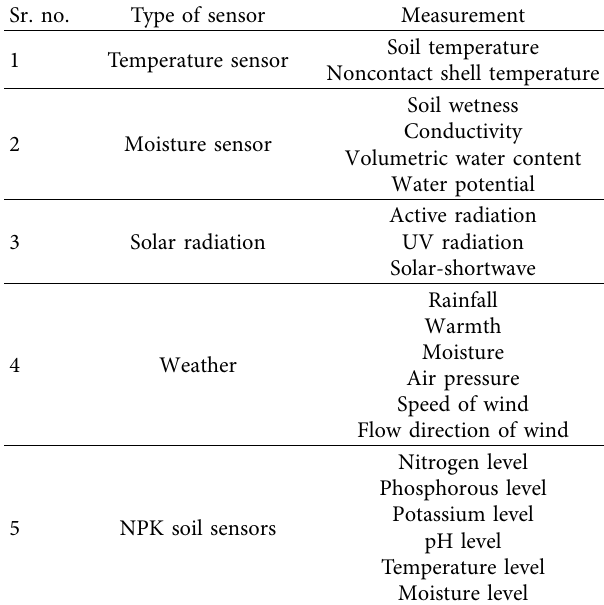
Table 1: Sensors and types of measures considered by the re- spective